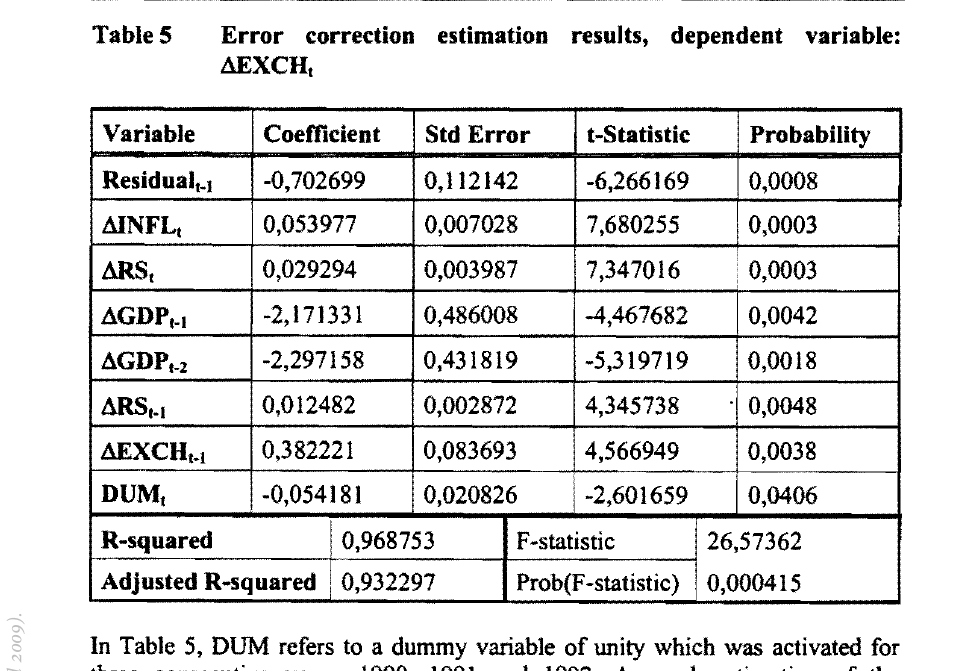
Error correction estimation results, dependent